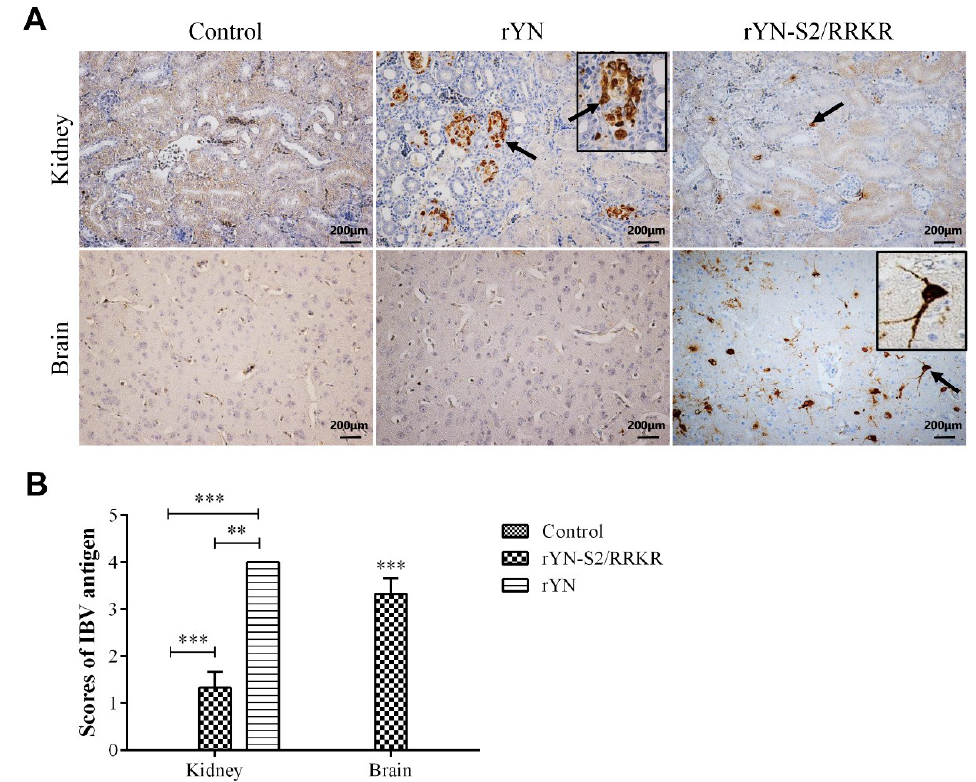
Figure 5. Results of IHC. ( A ) Results of IHC for IBV antigen in kidney and brain sections. The presence of rYN or rYN-S2/RRKR antigen was detected in the renal tubular epithelial cells, while substantial IBV antigen was detected in neurons of the brain from the rYN-S2/RRKR-inoculated group. ( B ) The detection of IBV was evaluated as the number of positive cells per section from each microscopic field through a ranked score of 0–4. The indications for the scores were as follows: 0 = no positive cells, 1 = 1–10 positive cells, 2 = 11–30 positive cells, 3 = 31–50 positive cells and 4 = > 50 positive cells. There were more rYN-positive cells in the kidney than for rYN-S2/RRKR, while there were no positive cells in brains of both rYN and negative control groups. There were obvious rYN-S2/RRKR-positive cells in brains ( n = 3, right).